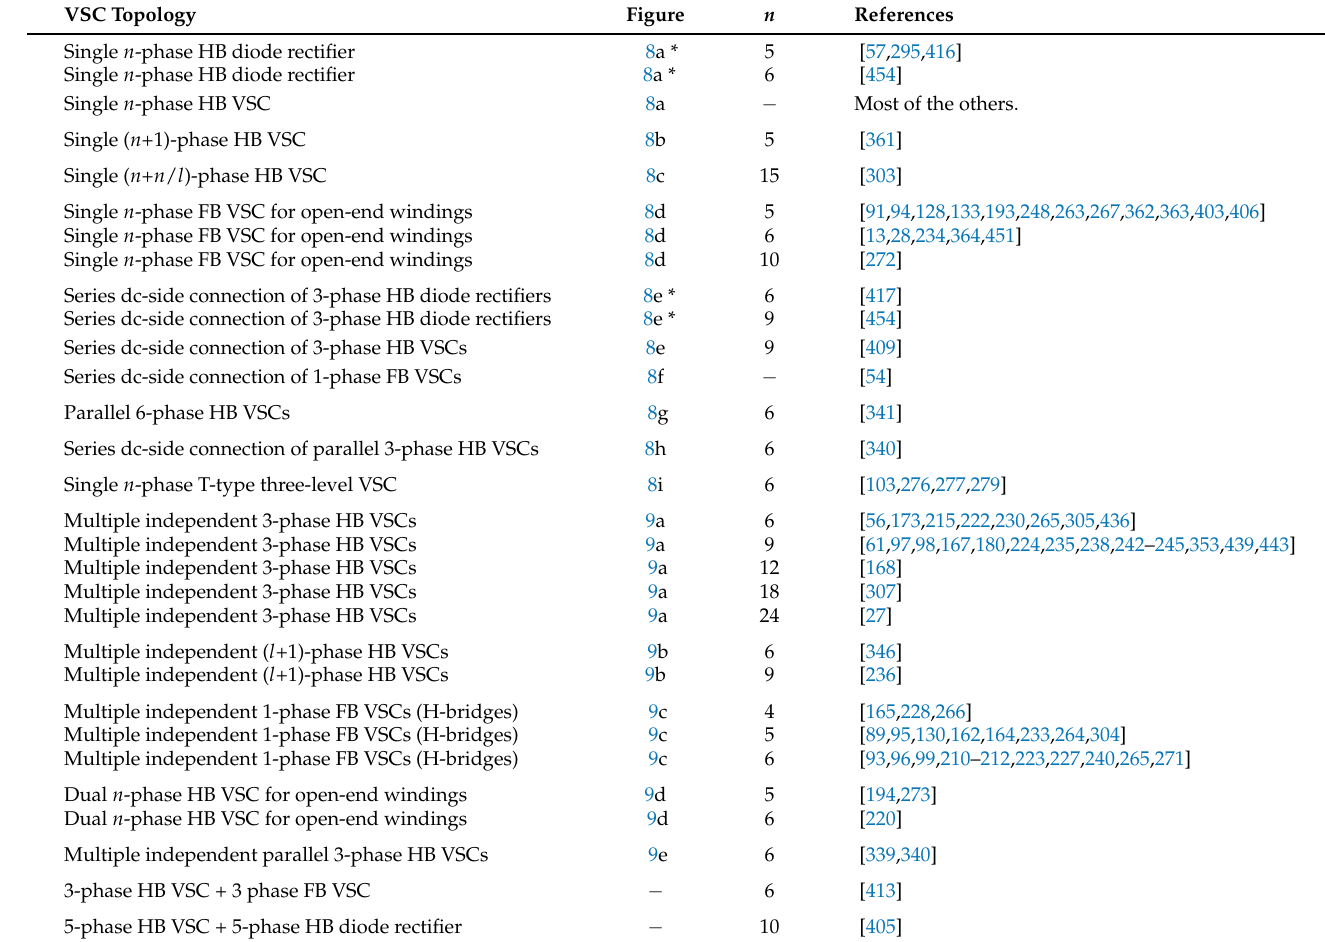
Table 6. Classification of references about fault tolerance in multiphase drives according to the VSC topology (Section 3.2), ignoring postfault